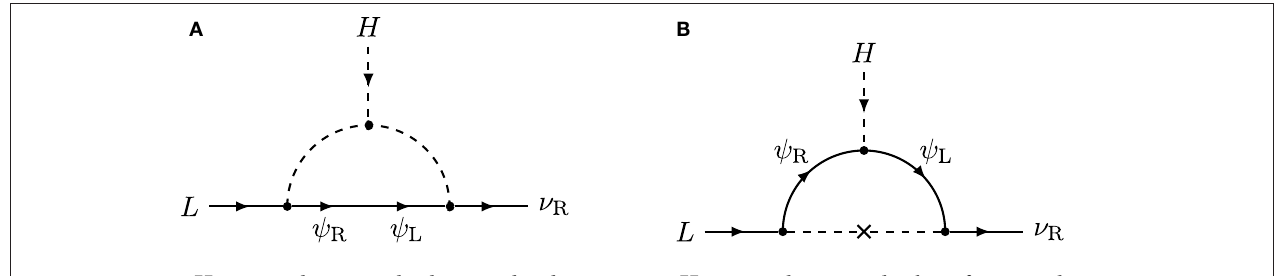
FIGURE 14 | Generation of the Dirac neutrino Yukawa coupling at 1-loop